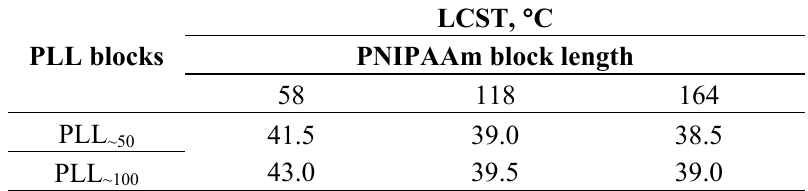
Table 5. Results from DLS measurements on synthesized PNIPAAm-b-PLL diblock copolymers. Measurements were carried out with a 0.5 mg/mL solution.